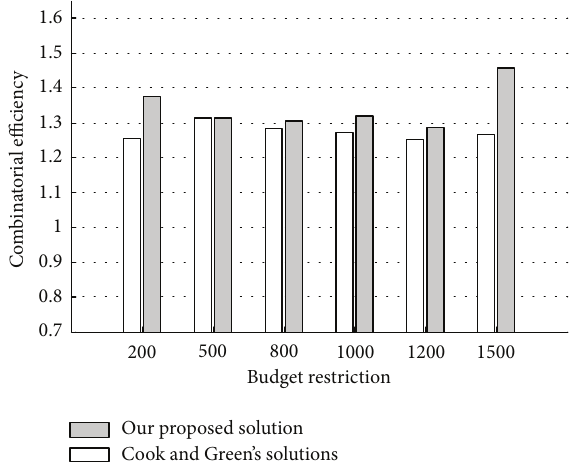
Figure 2: A comparison with different budget restrictions. in which different budget restrictions are introduced into Example 2. The comparison with different budget restrictions is also shown in Figure